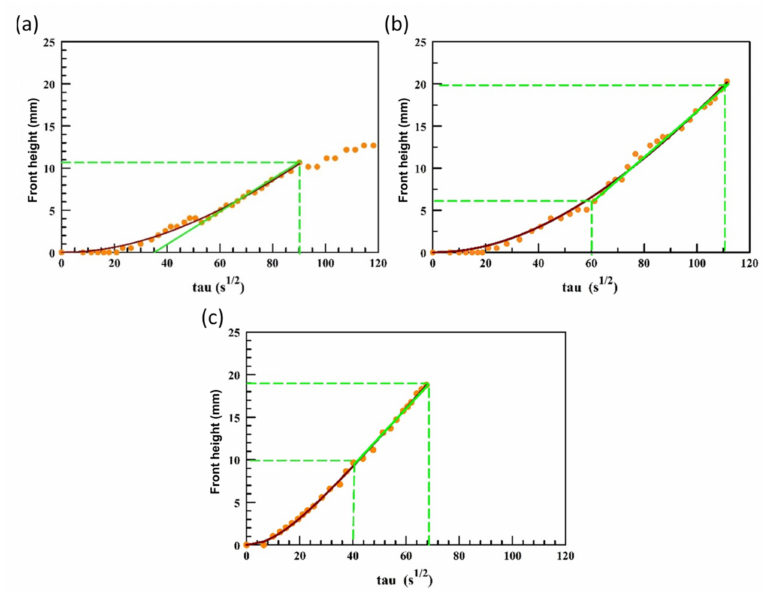
Figure 7. Height of the wetting front in coated Lecce stone specimens vs. the square root of time of water absorption through the treated face. ( a ) FSC2-PFPEsol coating (APL1); ( b ) FSC2 PFPEsusp coating (APL2); ( c ) N215 coating (APL6). Green lines refer to the linear fits by Equation (4) of the data points on the longest times of the curve; Red lines refer to the fits by Equation (5).